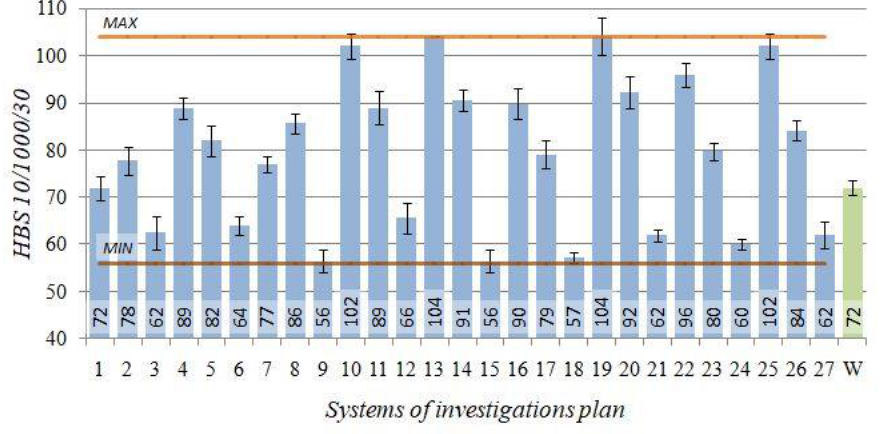
Figure 8. Hardness HBS 10/1000/30 — the initial state (W) and after T6 heat treatment (1 – 27) for the EN AC – AlSi11(Fe) alloy.